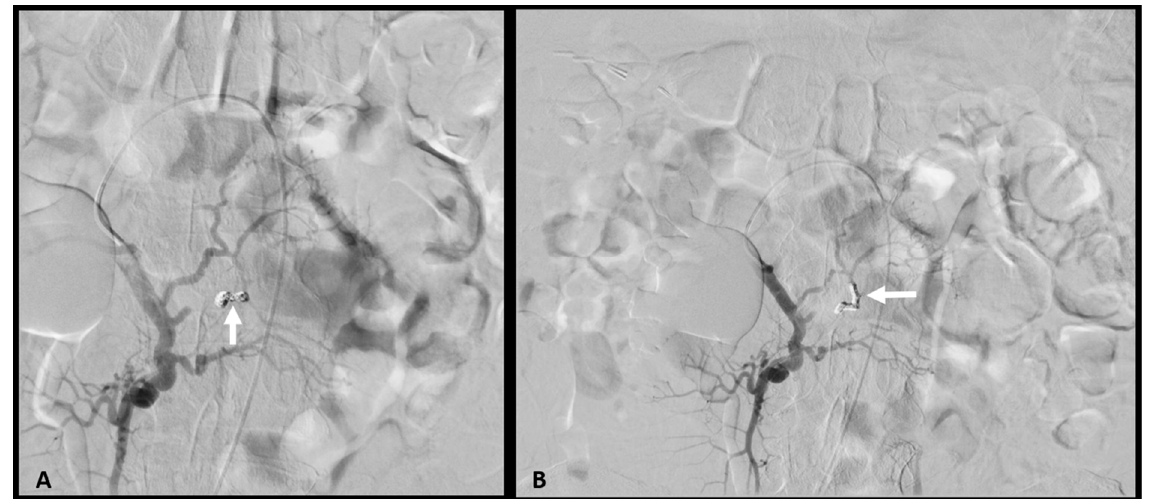
Figure 3. Transcatheter arterial embolization with coils of the pseudoaneurysm. ( A ) Angiogram after the first procedure showing complete occlusion of the 2nd JA (arrow). ( B ) Angiogram after the second procedure demonstrating complete occlusion of the distal branch of the 1st JA (arrow), with residual filling of the pseudoaneurysm trough the proximal